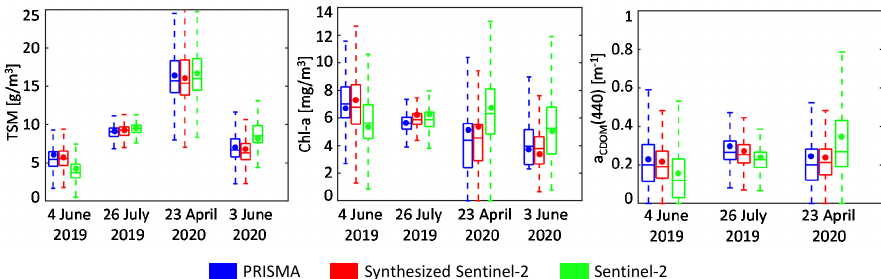
Figure 8. Multitemporal CDOM maps derived from PRISMA, synthesized Sentinel-2 (PRISMA resampled), and Sentinel-2 images.